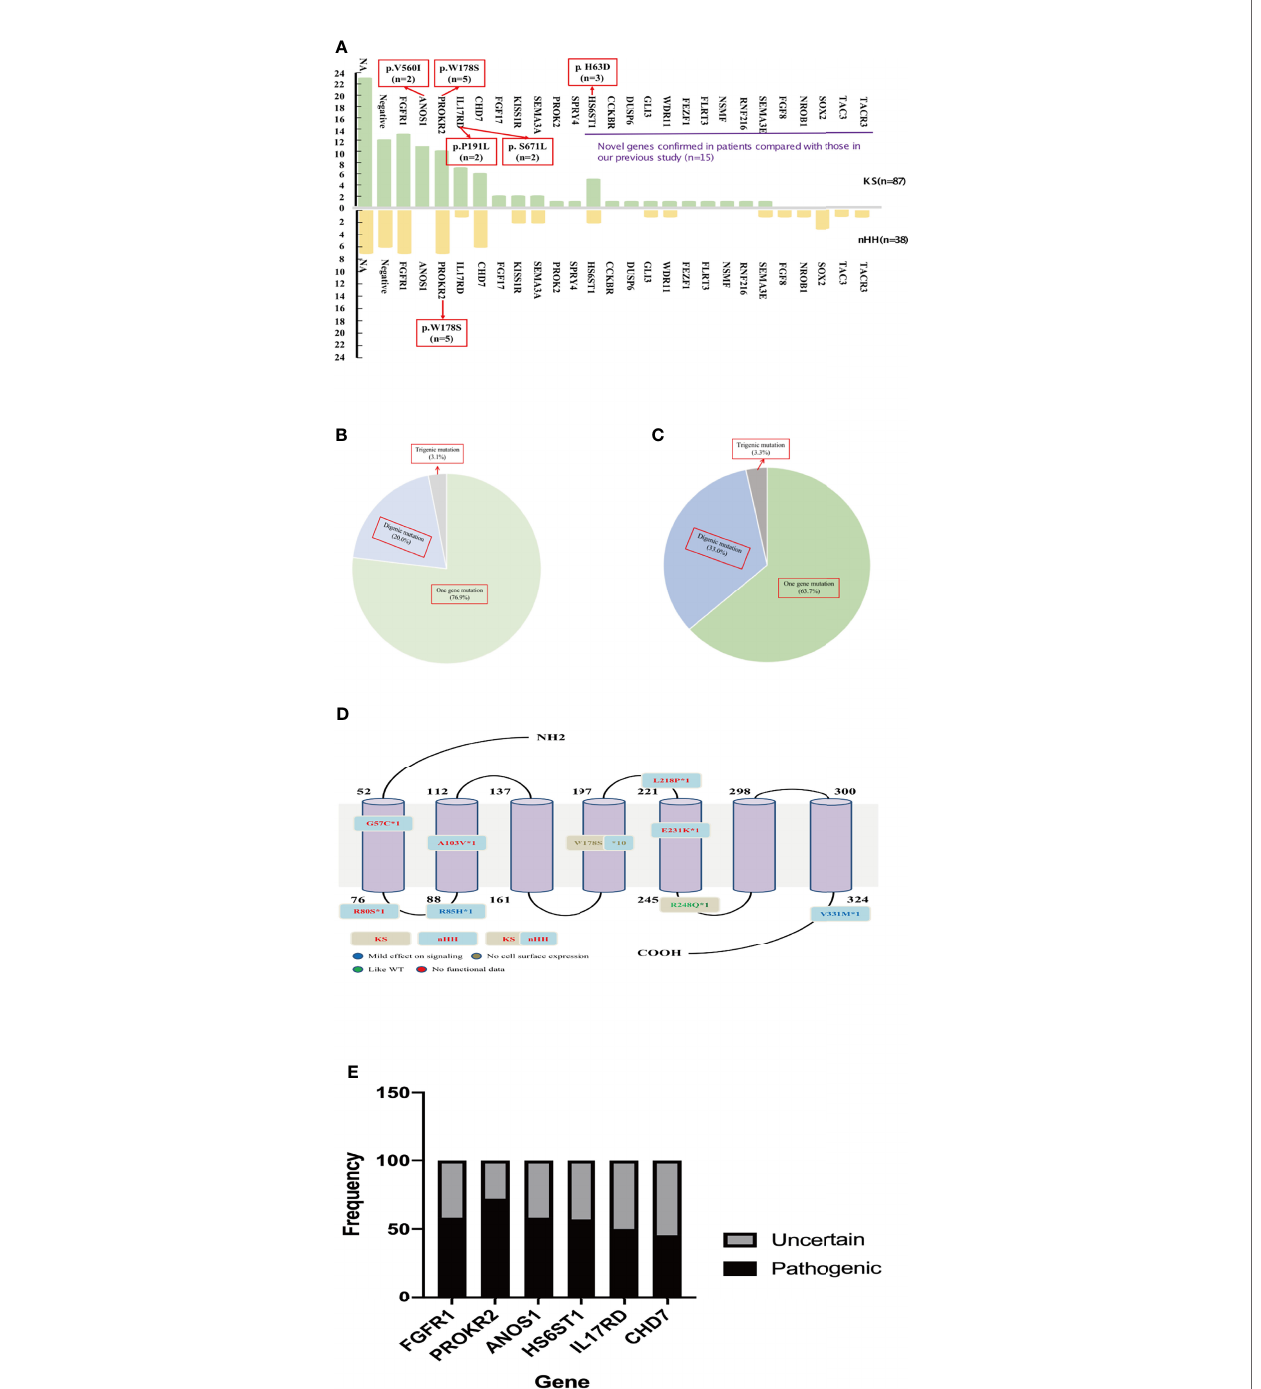
FIGURE 3 | Gene analysis of 125 patients. (A) The gene distribution of patients with KS and nHH. As can be seen from the Figure 2A , 15 new genes were con fi rmed in patients compared with our previous report. Multiple genes ( ANOS1 , PROKR2 , IL17RD and HS6ST1 ) were found to have repeated mutation sites. The gene of the patient with CHARGE syndrome was classi fi ed as nHH. (B) Digenic and trigenic gene mutations accounted for nearly a quarter of KS patients; (C) Digenic and trigenic gene mutations accounted for more than one third of nHH patients. (D) PROKR2 was one of the most common genes in CHH patients, 18 mutation sites were found in 17 patients, mostly loctated in transmembrane region and intracellular segment, and W178S accounted for 58.8% (10/17 patients), which may could be as the founder mutation of Chinese CHH patients. (E) We further analyzed the ratio of common gene pathogenic/possible pathogenic mutations to uncertain mutation sites in this study, and found that 45.5% - 75.0% of the mutation sites were pathogenic or like pathogenic. For patients with uncertain mutation sites, we need longer follow-up to con fi rm its diagnosis and mutation